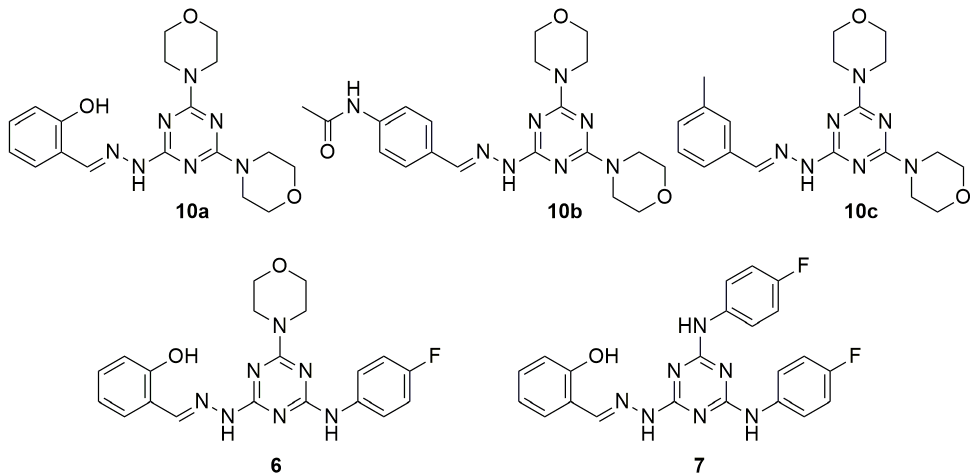
Figure 2. Structure of compounds 6 , 7 , 10a–c .